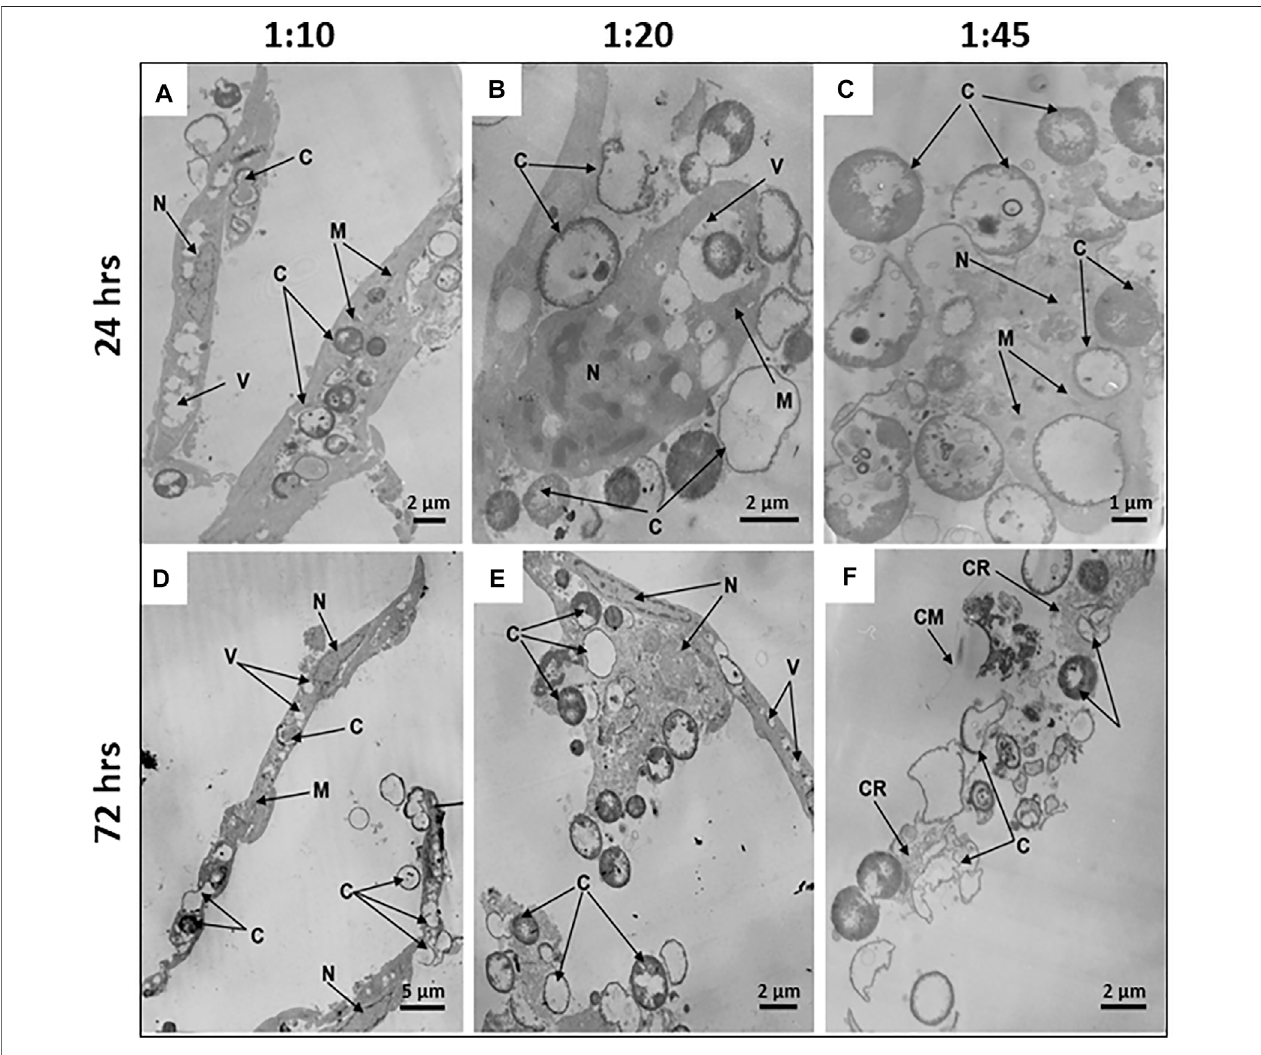
FIGURE 5 | Microcapsule internalization induces dose- and time-dependent ultrastructural alterations of hMSCs. Representative transmission electron micrographs of hMSCswithmicrocapsulesat24and72 hpost-phagocytosisatvariouscell/microcapsuleratios(1:10,1:20,and1:45).At24 hpost-phagocytosishMSCsdisplaying (A) spindle- likeshape ata 1:10 cell/microcapsules ratio, (B) irregular shapeat a1:20ratio, or (C) signi fi cantly disrupted cellsat a1:45ratio.Themicrocapsules werelocated both insideand outsidethecells (A – C) . At72 h post-phagocytosis hMSCs displaying (D) spindle-likeshape, (E) irregular shape, or (F) weredamaged.Designations:C,microcapsules;N, nucleus; V, vacuole; M, mitochondria; M, mitochondrium; CR, residual cytoplasm; CR, cytoplasmic remnants; CM, cell